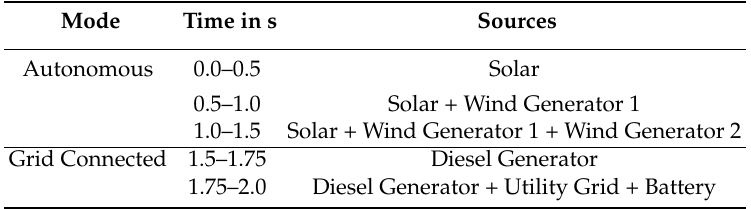
Table 5. Modes of operation with power from Various sources in DC bus system.